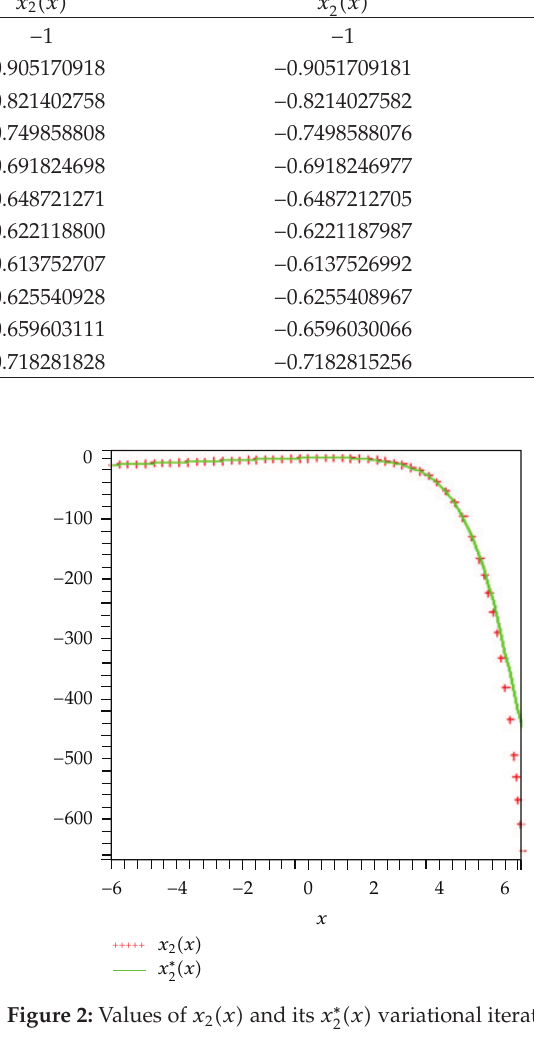
Figure 2: Values of x 2 (cid:3) x (cid:4) and its x ∗